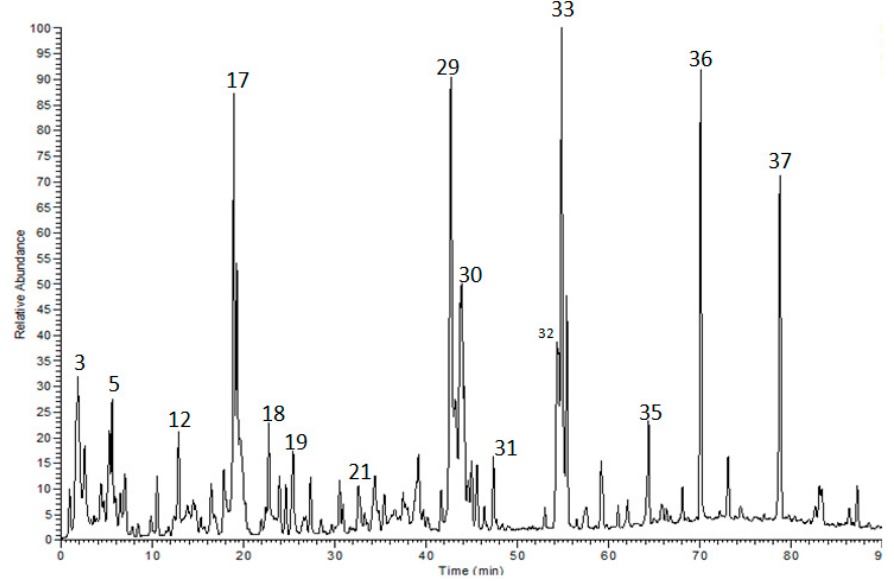
Figure 1. Negative HPLC-ESI-MS/MS profile of phenolic compounds from a methanol extract of Alpinia zerumbet leaves. Numbers at peaks refer to Table 1. Table 1. Phenolic compounds in the methanol extract via negative HPLC-ESI-MS/MS.